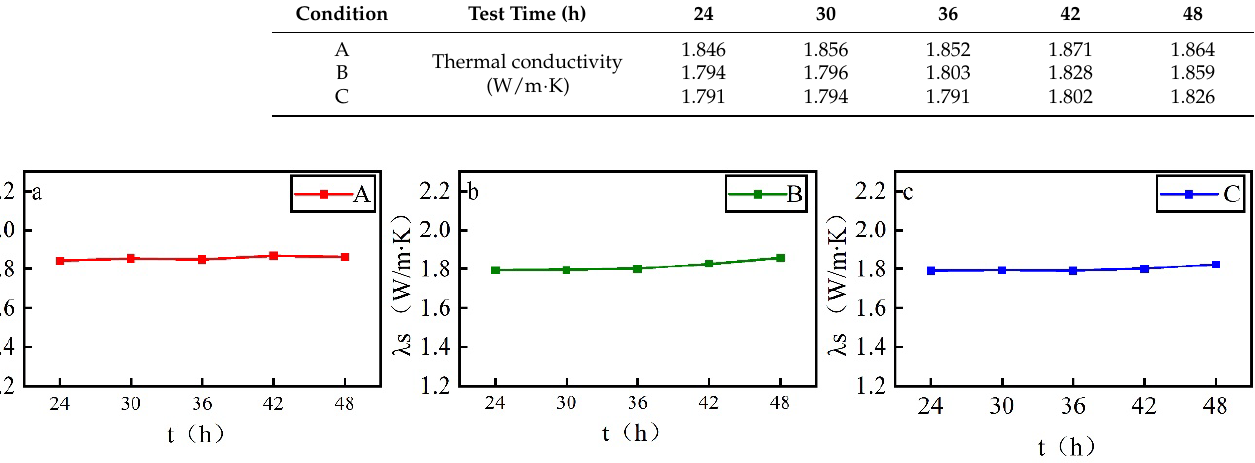
Figure 8. Thermal conductivity at the different time nodes. ( a ) Condition A. ( b ) Condition B. ( c ) Condition